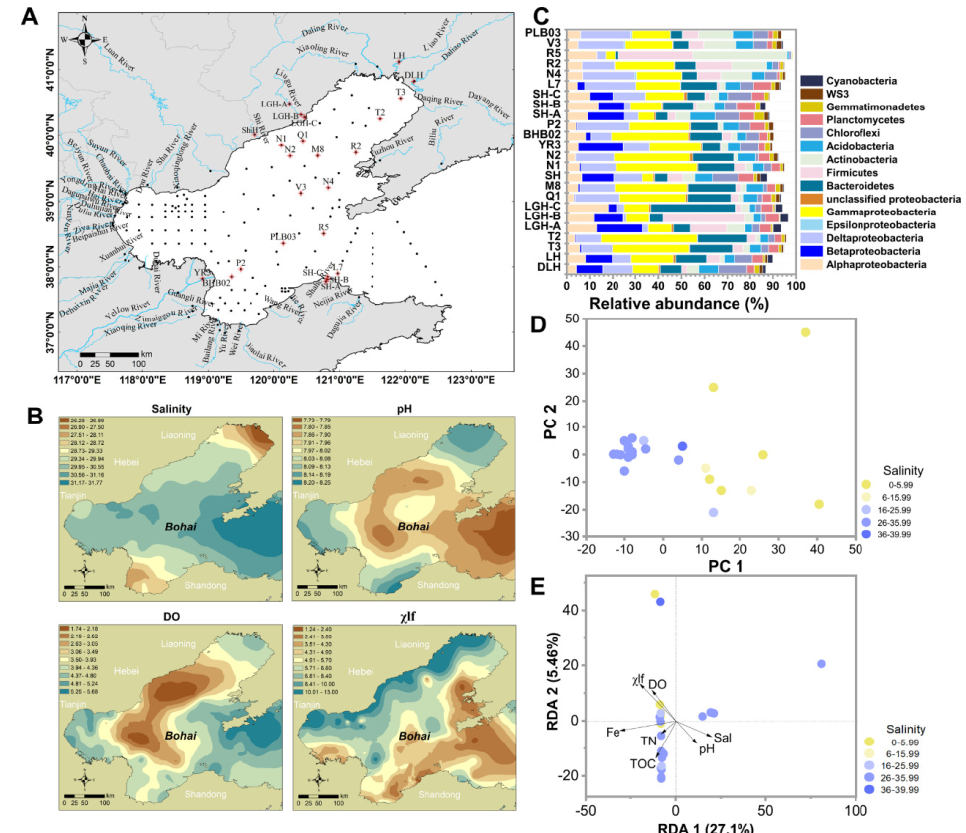
Figure 1. Study area, environmental variables, and microbial community composition. ( A ) A map of the study area. Black dots denote sampling sites. The letters denote site names. Red “ ⊕ ” indicates sites chosen for further study of microbial community structure, including Daliao River sites (DLH), Liao River (LH), Liugu River sites (LGH-A, LGH-B, and LGH-C), Shi River site (ShiH), Yellow River site (YR), Sha River sites (SH-A, SH-B, and SH-C), and sample sites located in the Bohai Sea (Q1, M8, T3, T2, N1, N2, L7, BHB02, PLB03, V3, N4, R2, R3, and R5). ( B ) Maps showing salinity, dissolved oxygen (DO), low-frequency magnetic susceptibility ( χ lf) of the sediment, and pH of the overlying water across the Bohai Sea. The maps were constructed using ArcGIS 10.0 software. ( C ) Microbial community composition in the study area at the phylum level (Proteobacteria showed by classes). ( D ) Principal component analysis (PCA) plot based on an OTU-based Bray-Curtis dissimilarity metric derived from the freshwater and marine sediment samples. ( E ) Redundancy analysis (RDA) plot of the bacterial communities and the main environmental